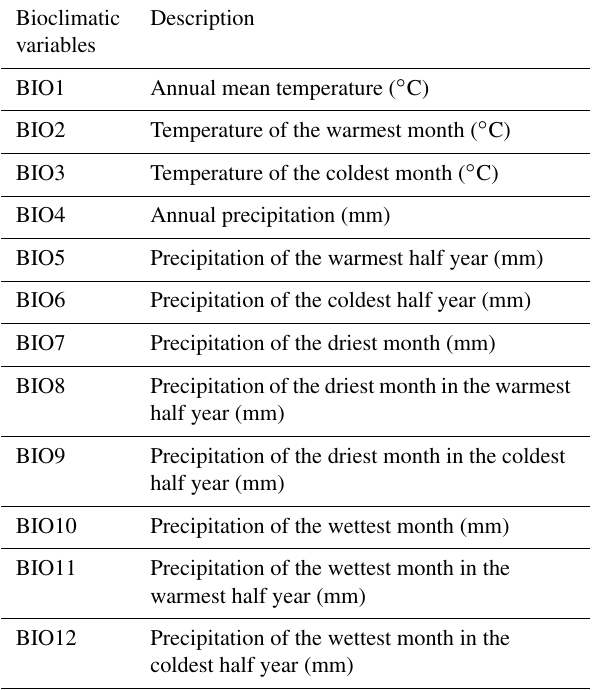
Table 5. List of bioclimatic variables derived from downscaled monthly climate